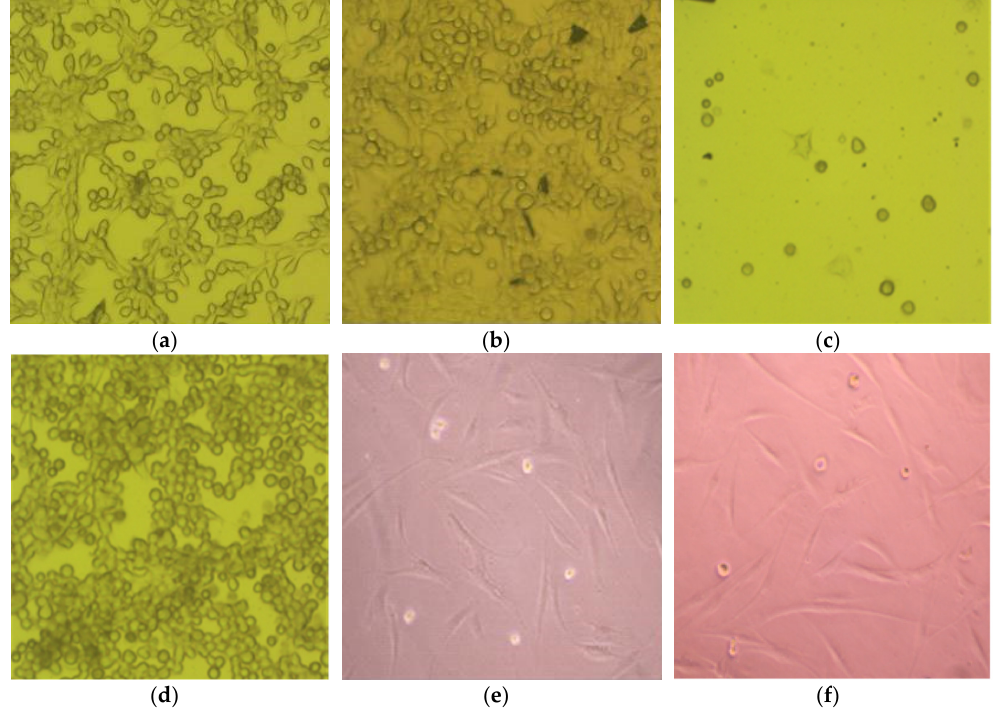
Figure 3. Phase contrast images of HDFs on ( a ) Si; ( b ) Si-APTES (–NH 2 end group); ( c ) GaAs; ( d ) GaAs-ODT (–CH 3 end group); ( e ) ITO and ( f ) ITO-ODT (–CH 3 end group) after 48 h (Bar represents 10 μ m).